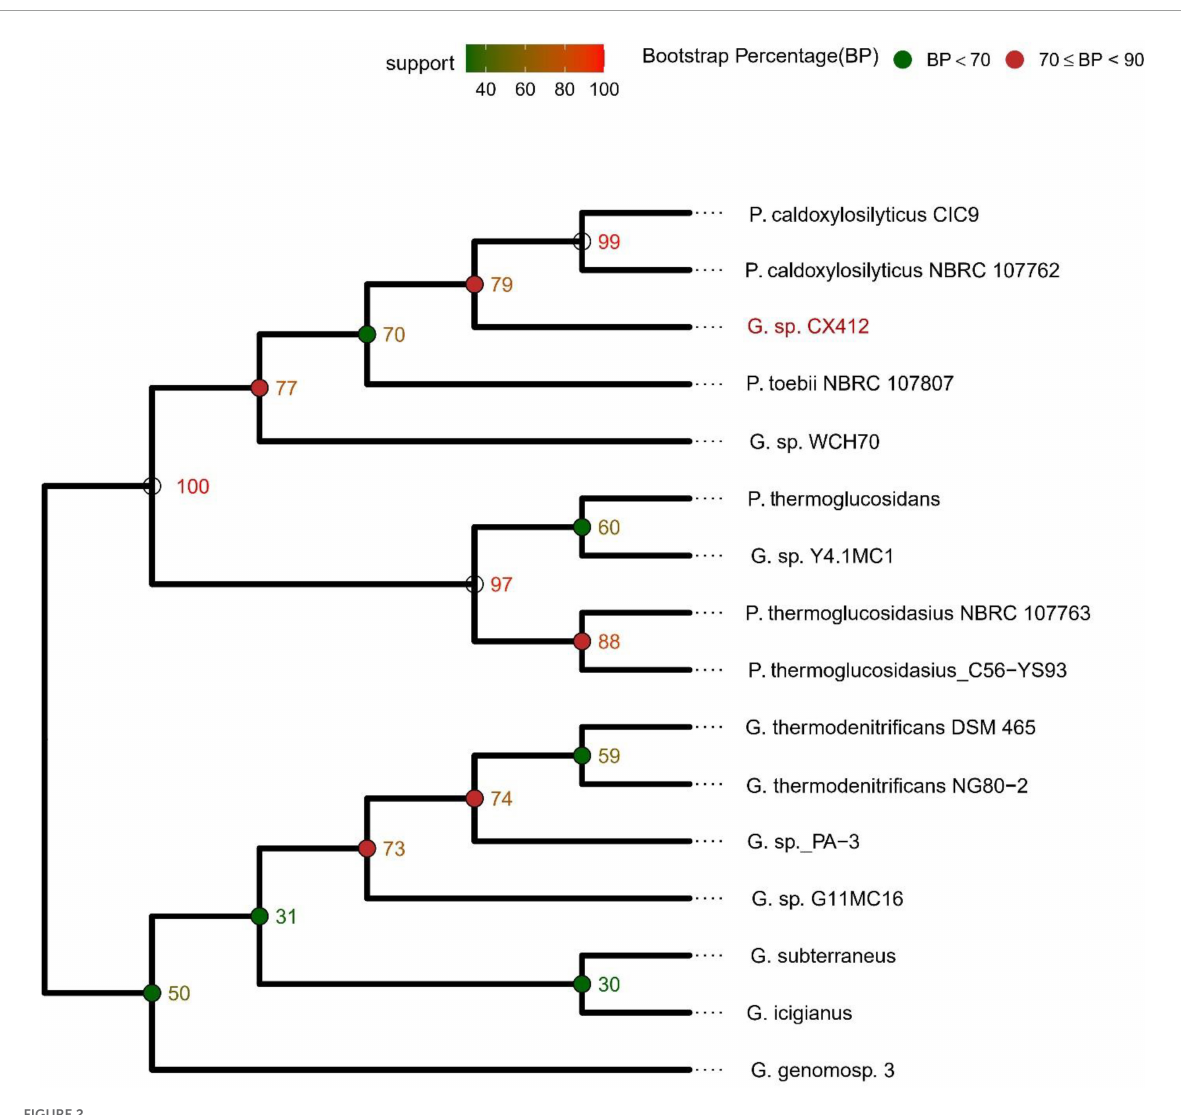
FIGURE2 16S rRNA-based phylogenetic tree. G., Geobacillus ; P., Parageobacillus